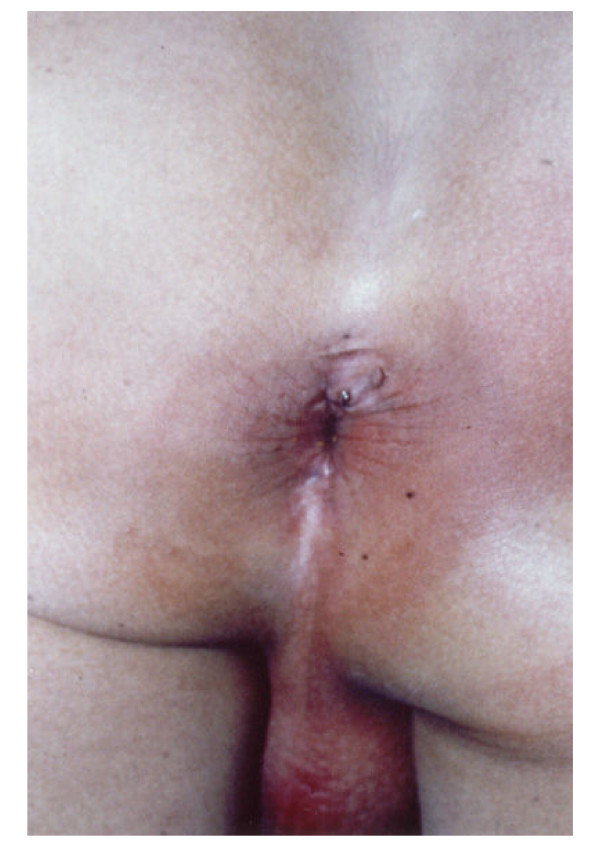
Thiersch's wire is shown eroding through the perianal skin.